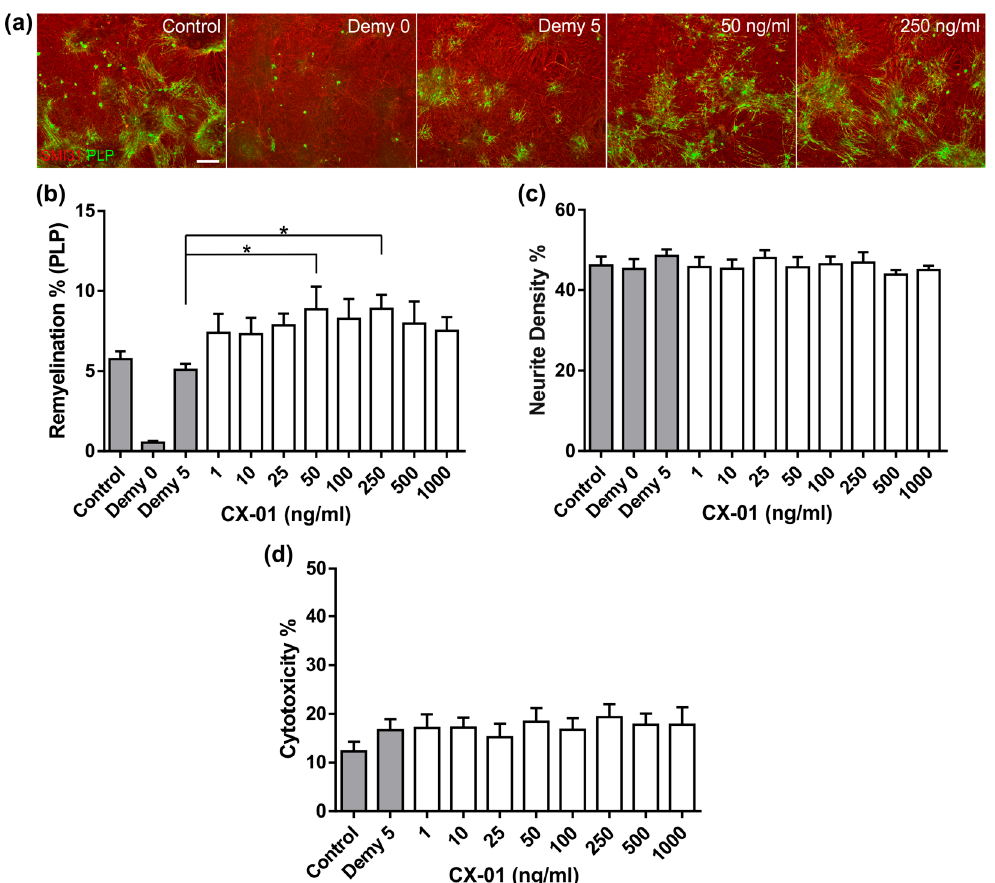
Figure 5. CX-01 promotes remyelination in MC-Demy. ( a ) MC-Demy was treated with CX-01 at 25 DIV, followed by immunolabelling with SMI31 (red, neurites) and PLP (green, myelin) 5 days later. Representative images of control cultures or those treated with anti-MOG and complement on either 25 DIV (Demy 0), or 30 DIV (Demy 5) and following CX-01 treatment at 50 ng/ml and 250 ng/mL. ( b ) Quantification showing treatment with CX-01 resulted in an average 75% increase in remyelination compared to the non-treated demyelinated control cultures on day 5 (Demy 5) at 50 ng/mL and 250 ng/mL (one-way ANOVA with Dunnett multiple comparison, * p = 0.0238 and 0.0222). ( c ) Quantification of neurite density showed no effect. ( d ) Conditioned media from the cultures were collected at 28 DIV, 2 days prior to immunolabelling, and used to assess cytotoxicity based on LDH levels. Quantification of cytotoxicity showed no change after treatment implying no adverse toxic effects on the cultures. Scale bars represent 100 µm in all images, error bars + SEM (n = 6; technical replicates = 3). Previously, we demonstrated using a panel of mHeps that the level of sulphation effected their potential to promote re/myelination and neurite outgrowth as well as decreasing characteristics of astrogliosis with only low sulphated mHeps promoting repair [11–13]. Moreover, their mechanism-